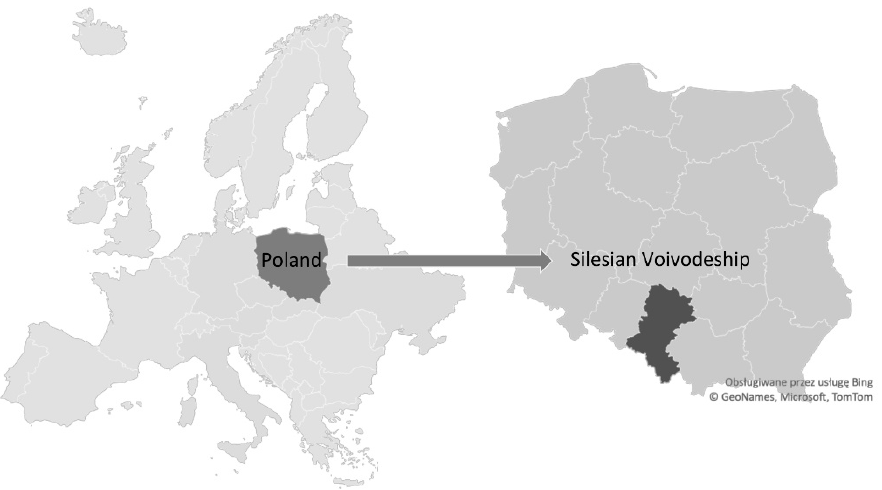
Figure 1. The place of the survey (map developed using MS Excel